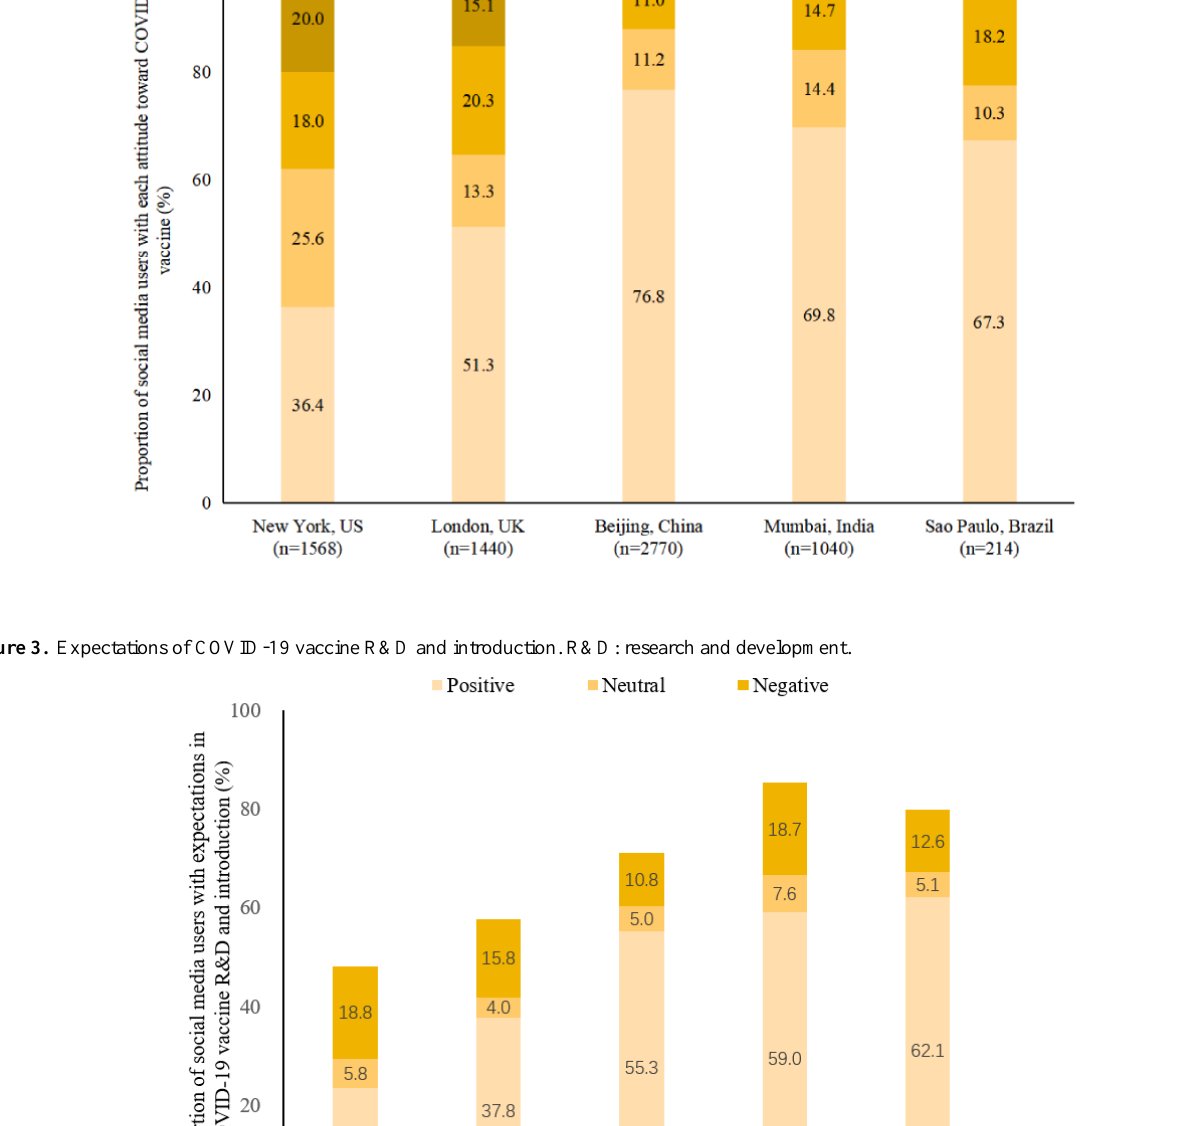
Figure 2. Social media users’attitudes toward COVID-19 vaccination.